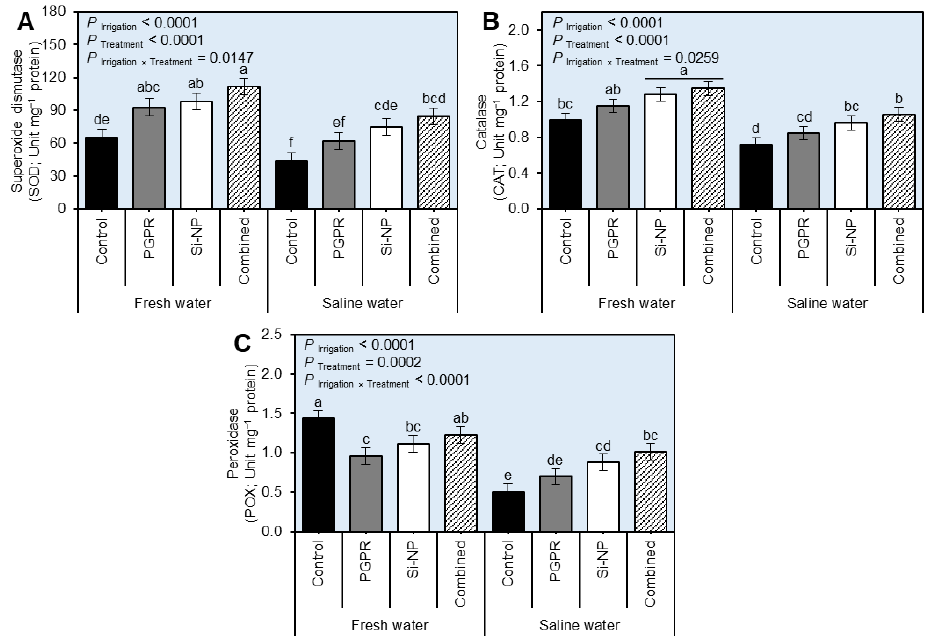
Figure 6. Effect of seed inoculation with PGPR and/or Si-NP foliar application on the water relations and chlorophyll reading of sugar beet plants grown in salt-affected soil and subjected to saline water irrigation during the 2019/2020 seasons. ( A ) Superoxide dismutase (SOD; Unit mg −1 protein), ( B ) catalase (CAT; Unit mg −1 protein), and ( C ) peroxidase (POX; Unit mg −1 protein) during the 2019/2020 seasons, respectively. Data presented are the means ± standard deviation (mean ± SD) of three biological replicates. Different letters signify statistically significant differences between treatments according to Tukey’s HSD test ( P Irrigation × Treatment ≤ 0.05).